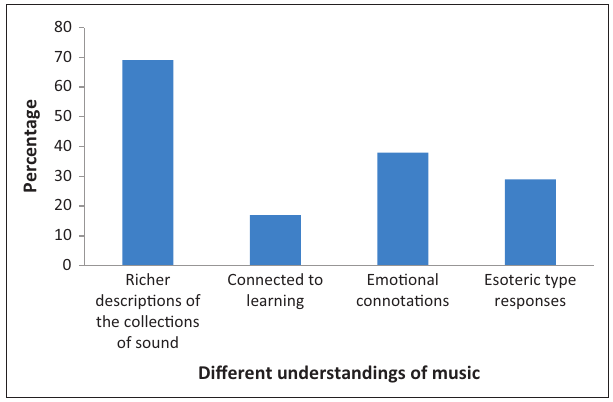
FIGURE 4: 2014 Post-course understandings of